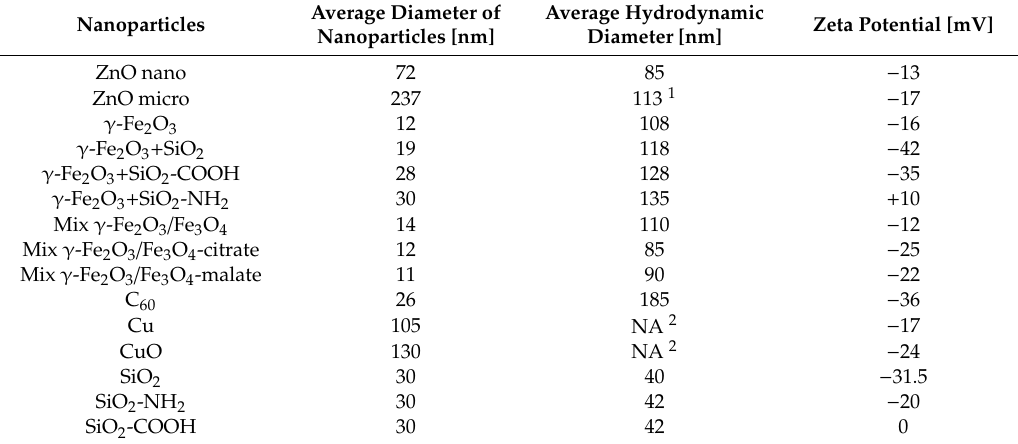
Table 1. Characteristics of nanoparticles. Average primary size was determined by the transmission electron microscopy (TEM). Average hydrodynamic diameter and zeta potential was determined in aqueous suspensions at 50 µ g · mL − 1